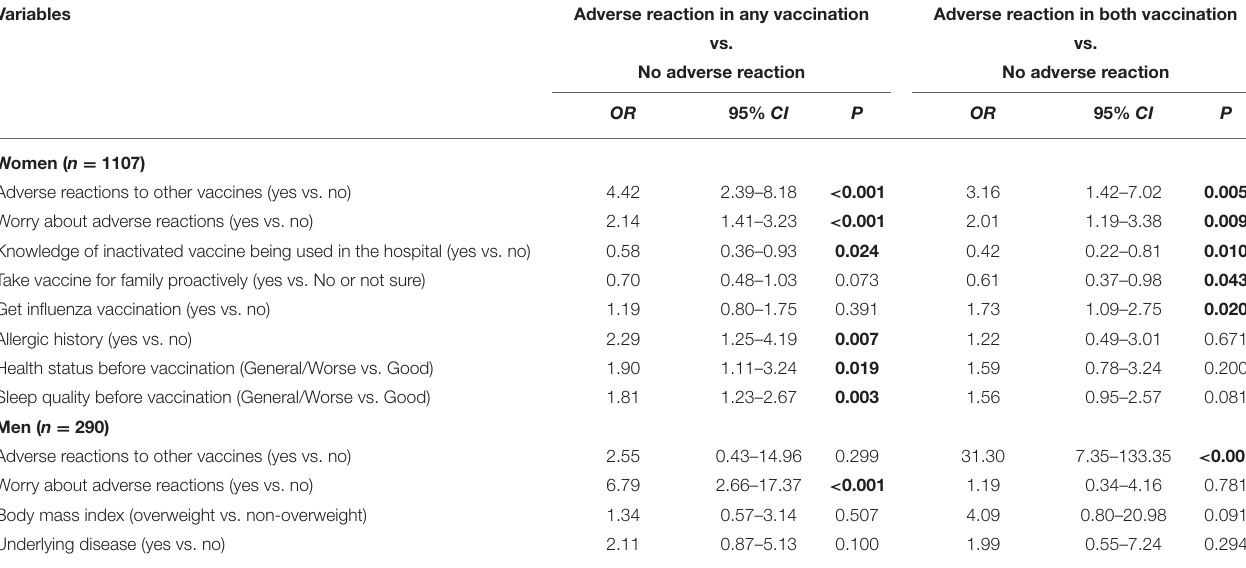
TABLE 3 | Multinominal logistic regression of associated factors for adverse reactions in women and men.